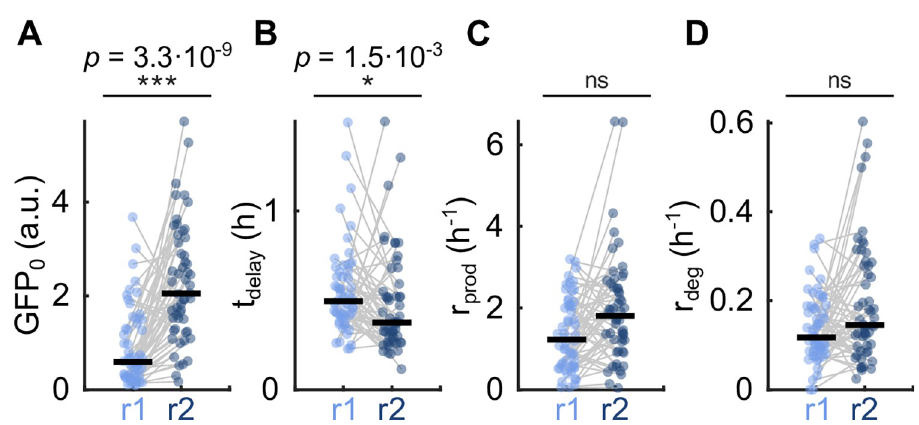
Fig 4. Shortened repression response delay mediates faster response upon repeated repression at single-cell level. Comparison of paired estimated single-cell parameters of cells with repression kinetics of repression r1 and r2 shows that the median initial total GFP, GFP 0 , and median repression delay, t delay , are significantly different ( p = 3.3 � 10 − 9 and p = 1.5 � 10 − 3 , respectively, two-sided paired sign test correcting for multiple testing with Bonferroni correction, m = 12, and the number of paired cells = 54), with median GFP 0 increased and median t delay decreased (median t delay values of 0.50 and 0.38 for r1 and r2, respectively). GFP degradation is not different between repressions r1 and r2 ( p =